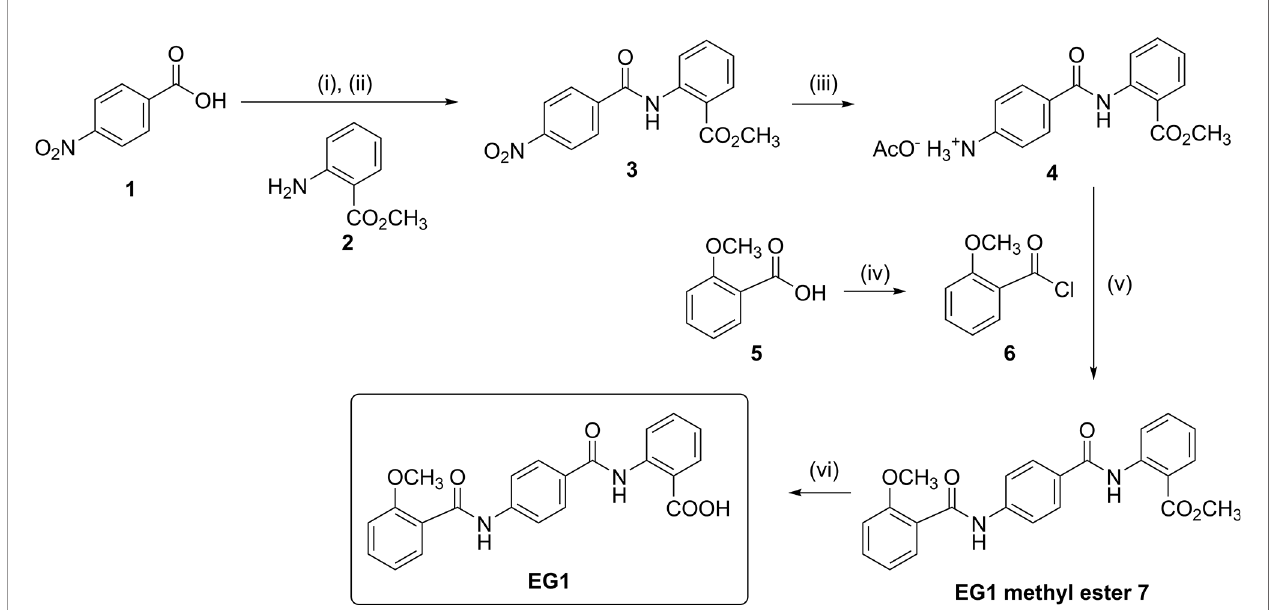
FIGURE 1 | Chemical synthesis of EG1. Reagents and conditions: (i) SOCl 2 , DMF, CH 2 Cl 2 , re fl ux, 6 h; (ii) 2, DIPEA, CH 2 Cl 2 , 0°C to rt, 5 h, 68%; (iii) H 2 , Pd/C (10% wt.), AcOH:CH 2 Cl 2 :EtOAc (1:10:30), 35-40°C, 22 h, 79%; (iv) (COCl) 2 , DMF, CH 2 Cl 2 , re fl ux, 1.5 h; (v) DIPEA, DMF:CH 2 Cl 2 (1:4), 0°C to rt, 69 h, 60%; (vi) 0.5 M aqueous NaOH, THF, 30°C to rt, 16 h,